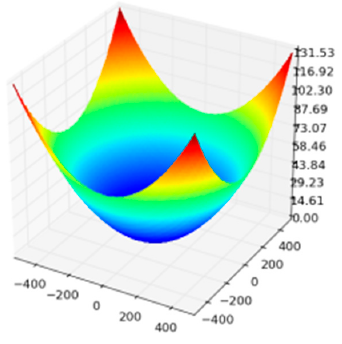
Figure 6. Griewank Function.